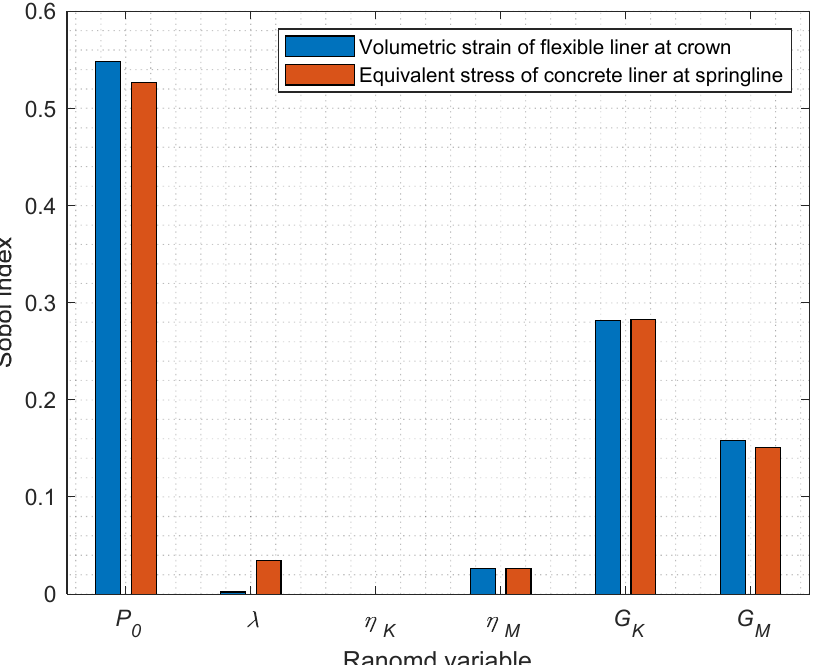
Figure 7. Sobol indices of the six random input parameters with respect to the two QoIs.